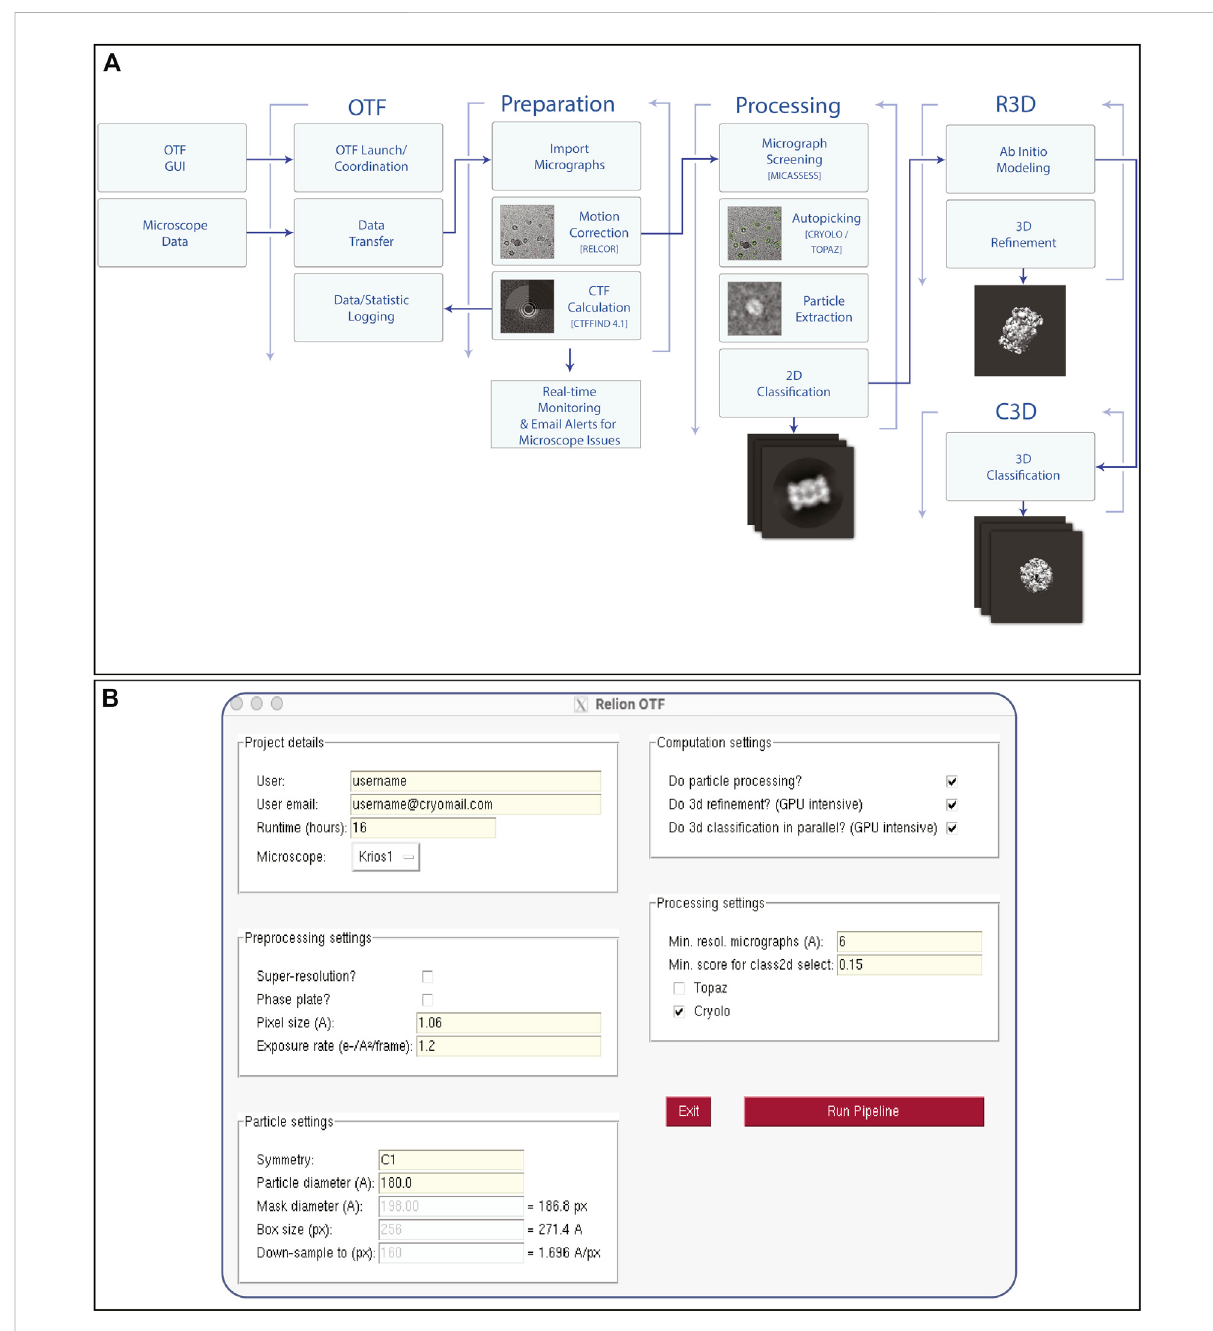
FIGURE 4 On-The-Fly Pre-Processing Pipeline. Once data collection begins on any microscope, the user will launch an on-the- fl y (OTF) pre-processing Scheme (A) via a graphical user interface (B) . once launched, various processing steps are initiated in real time such as motion correction, CTF estimation, as well as downstream particle picking, classi fi cation and re fi nement steps. Email alerts are sent to both the user and facility staff when resolution quality does not meet a certain threshold, or if data collection stops due to unexpected microscope